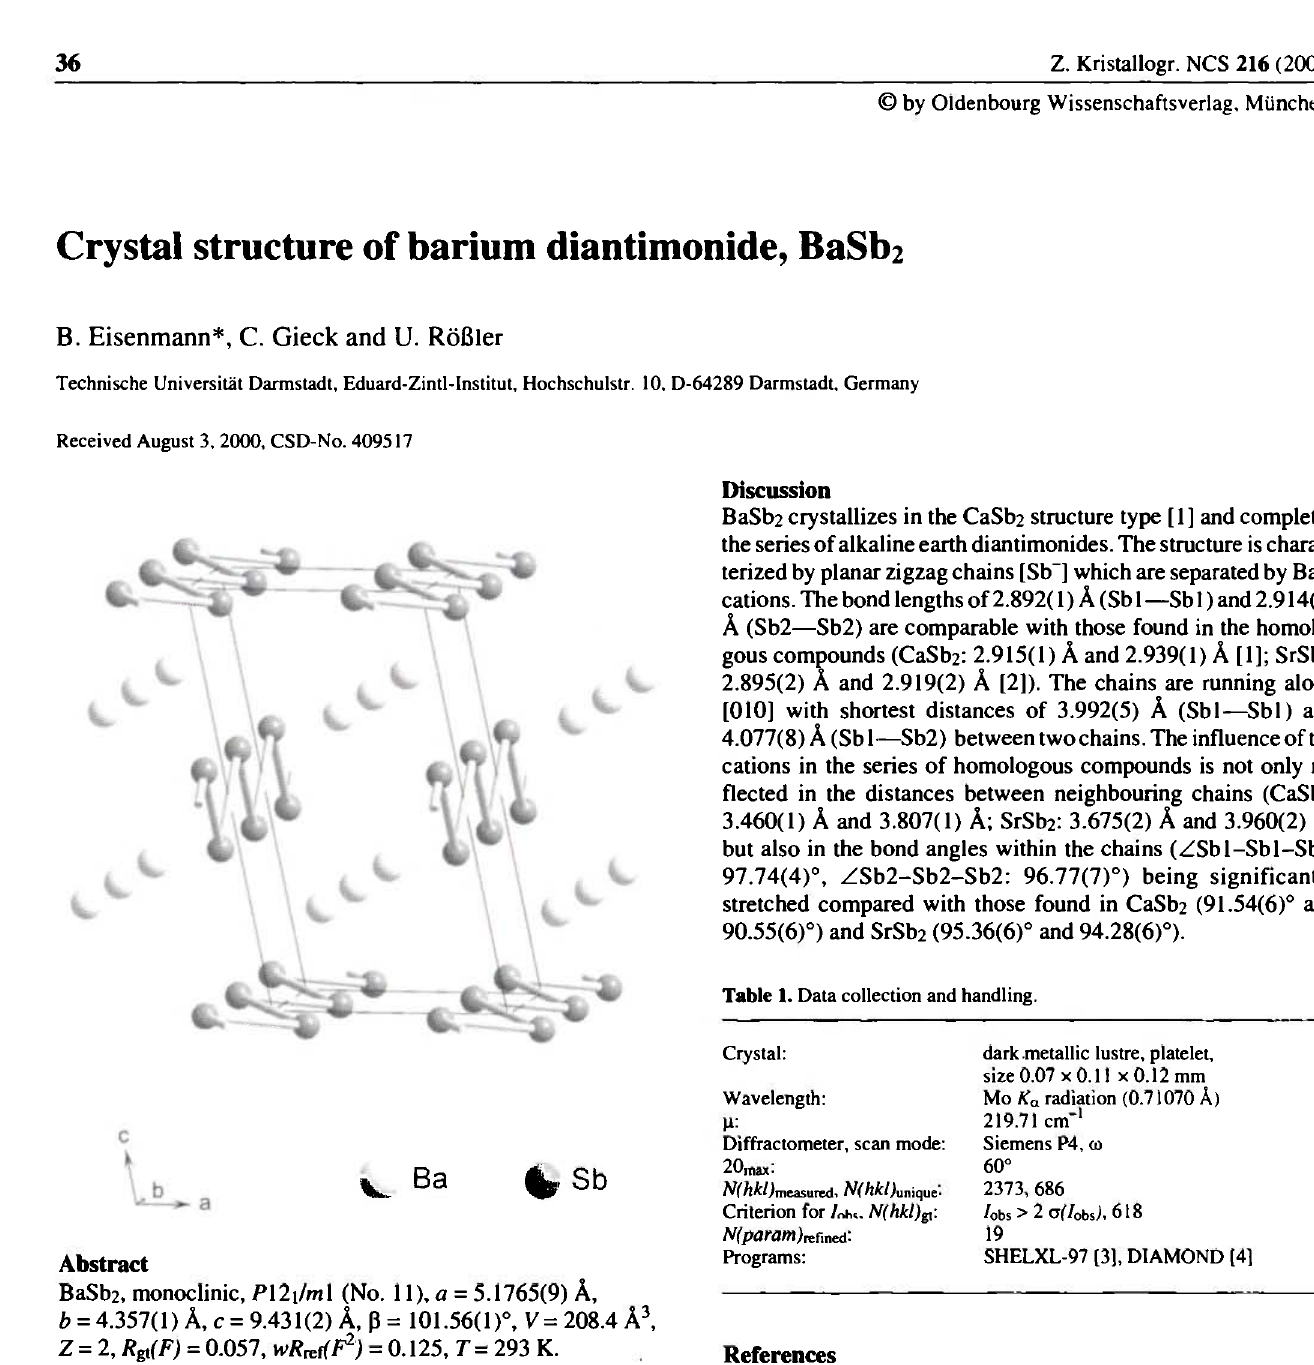
Table 1. Data collection and